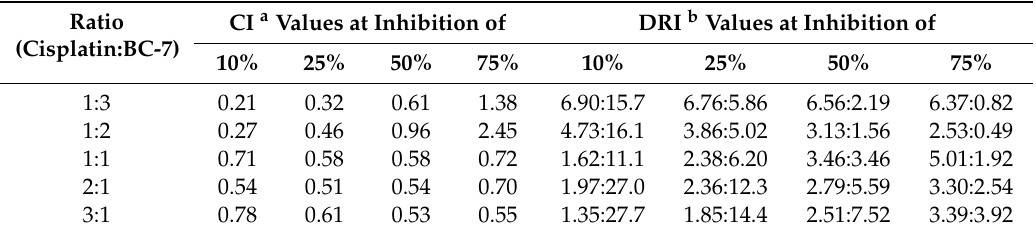
Table 7. Combination index (CI) and dose reduction index (DRI) values for combinations of cisplatin: BC-7 at inhibition of 10%, 25%, 50%, and 75% of HeLa cell